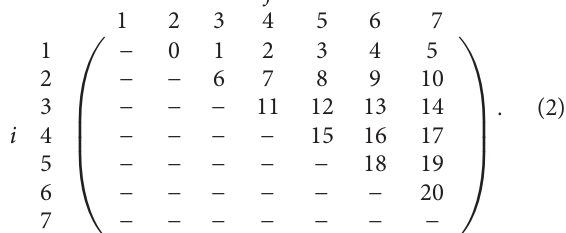
Algorithm 2: Outline of pattern reduction enhanced genetic algorithm